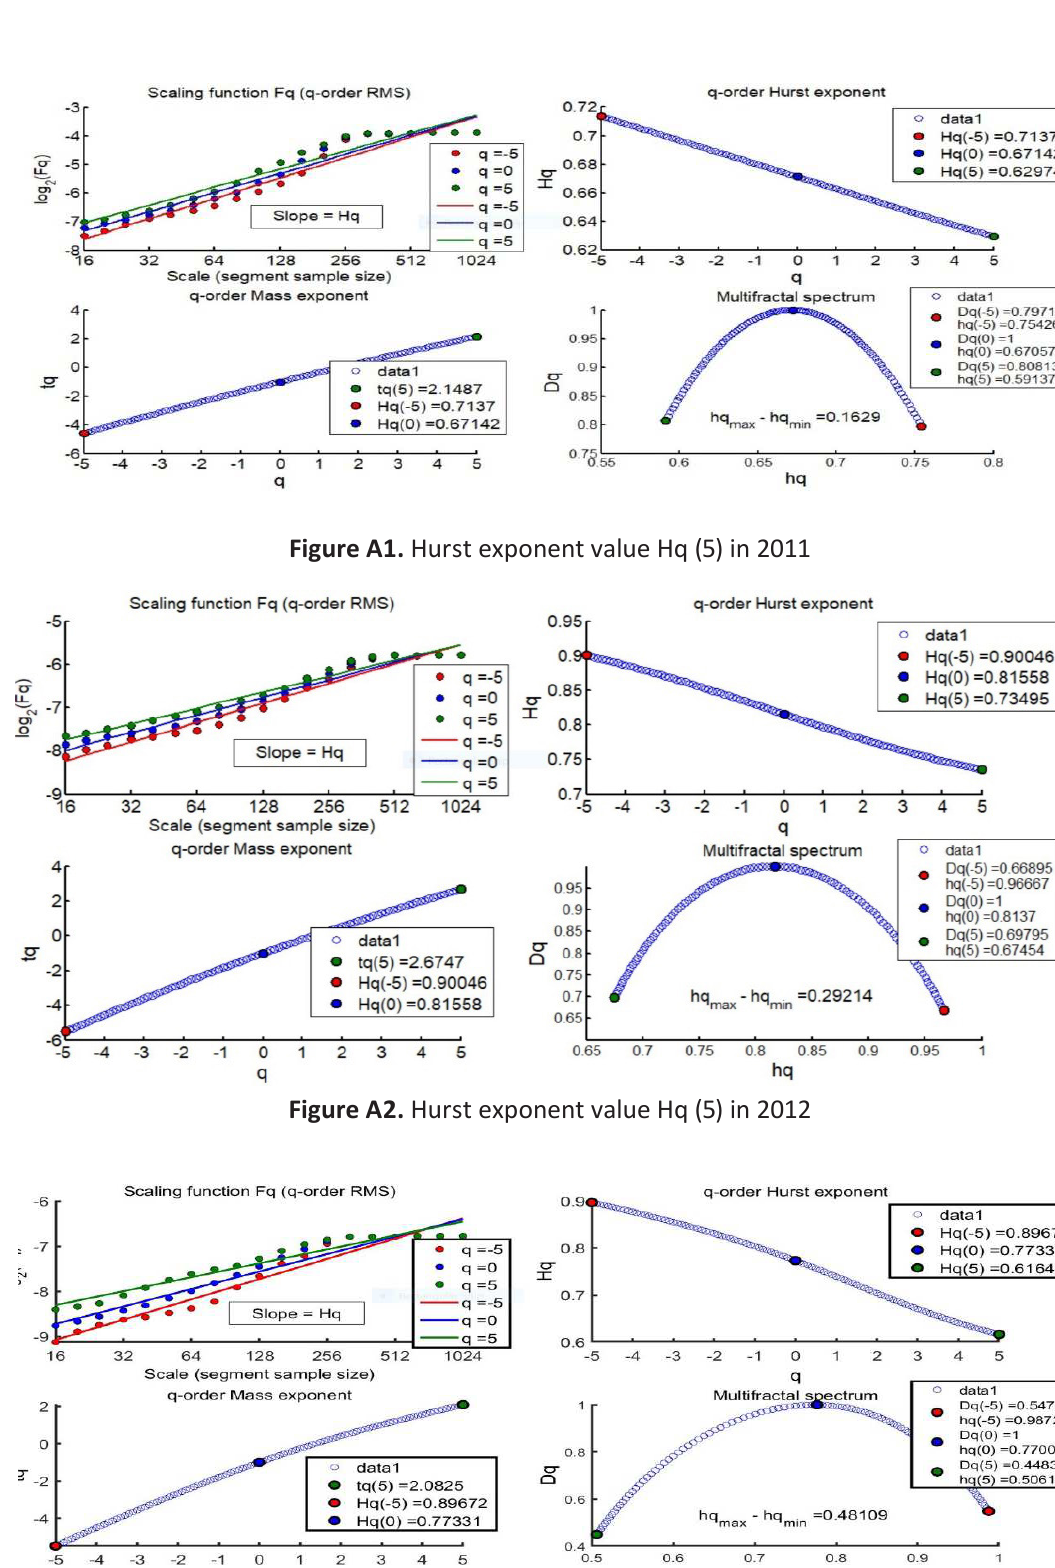
Figure A3. Hurst exponent value Hq (5) in